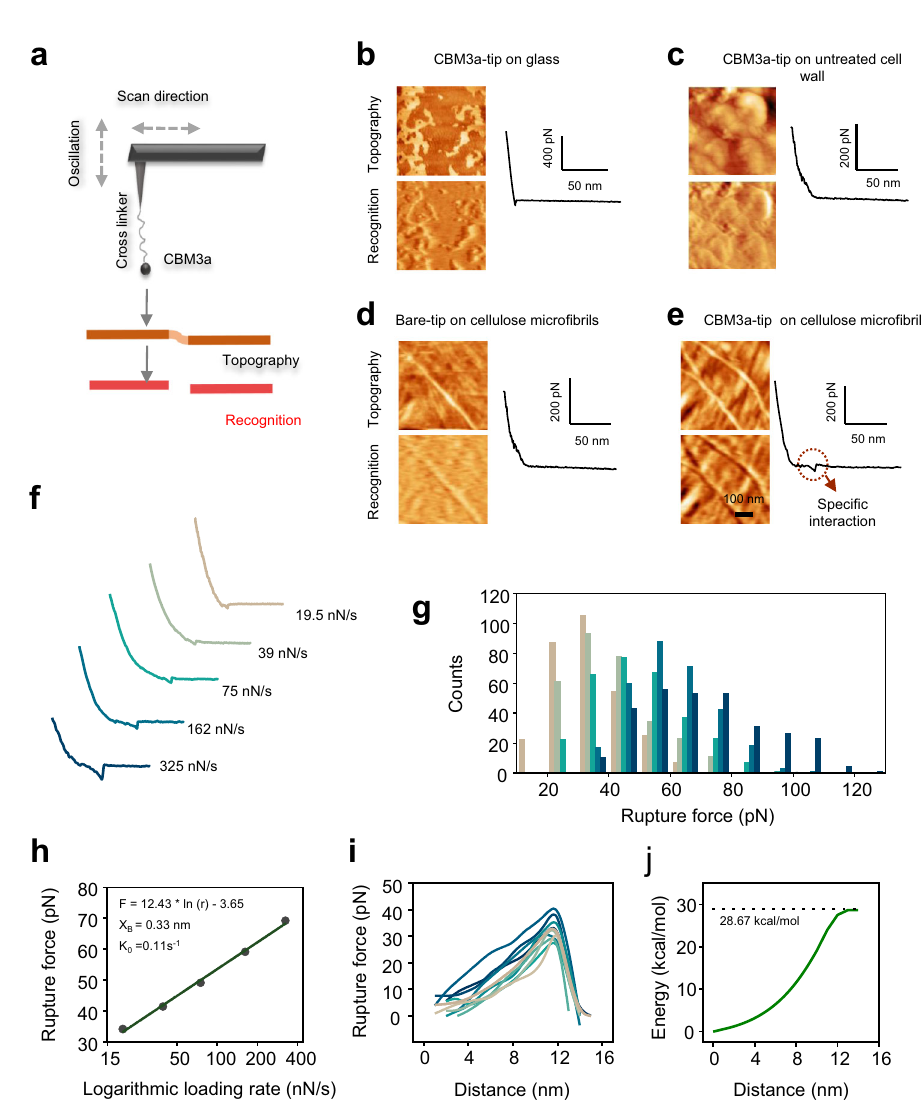
Fig. 2 | Recognition of crystalline cellulose with CBM3a-probe. a Schematics of the CBM3a-probed AFM speci fi c for binding with crystalline CMFs. b – e Control experiments for CBM3a interaction with CMF. f , g The distribution of interaction forcebetweenCBM3aand CMFatdifferentloadingrates. h Mostprobablerupture